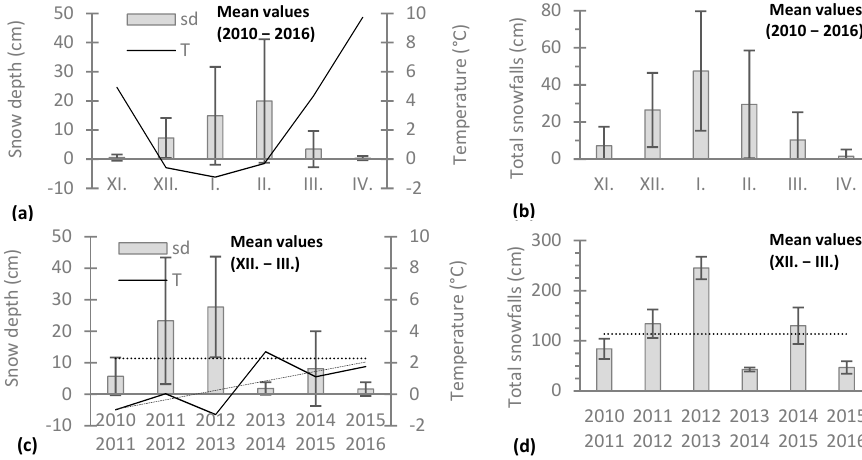
Figure 5. Mean ( a , b ) monthly and ( c , d ) seasonal values of the daily average snow depth (sd), daily average temperature (T), and total snowfall (sum of snowfalls). The horizontal dotted lines indicate the mean value from the displayed bar plot data. Bar plots are shown with SD.